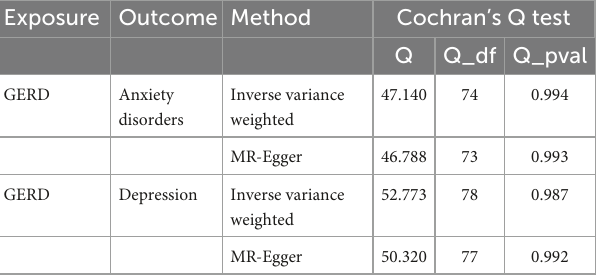
TABLE 7 Results of heterogeneity by the Cochran’s Q test (based on the IVs screened under the locus-wide significance threshold). Exposure Outcome